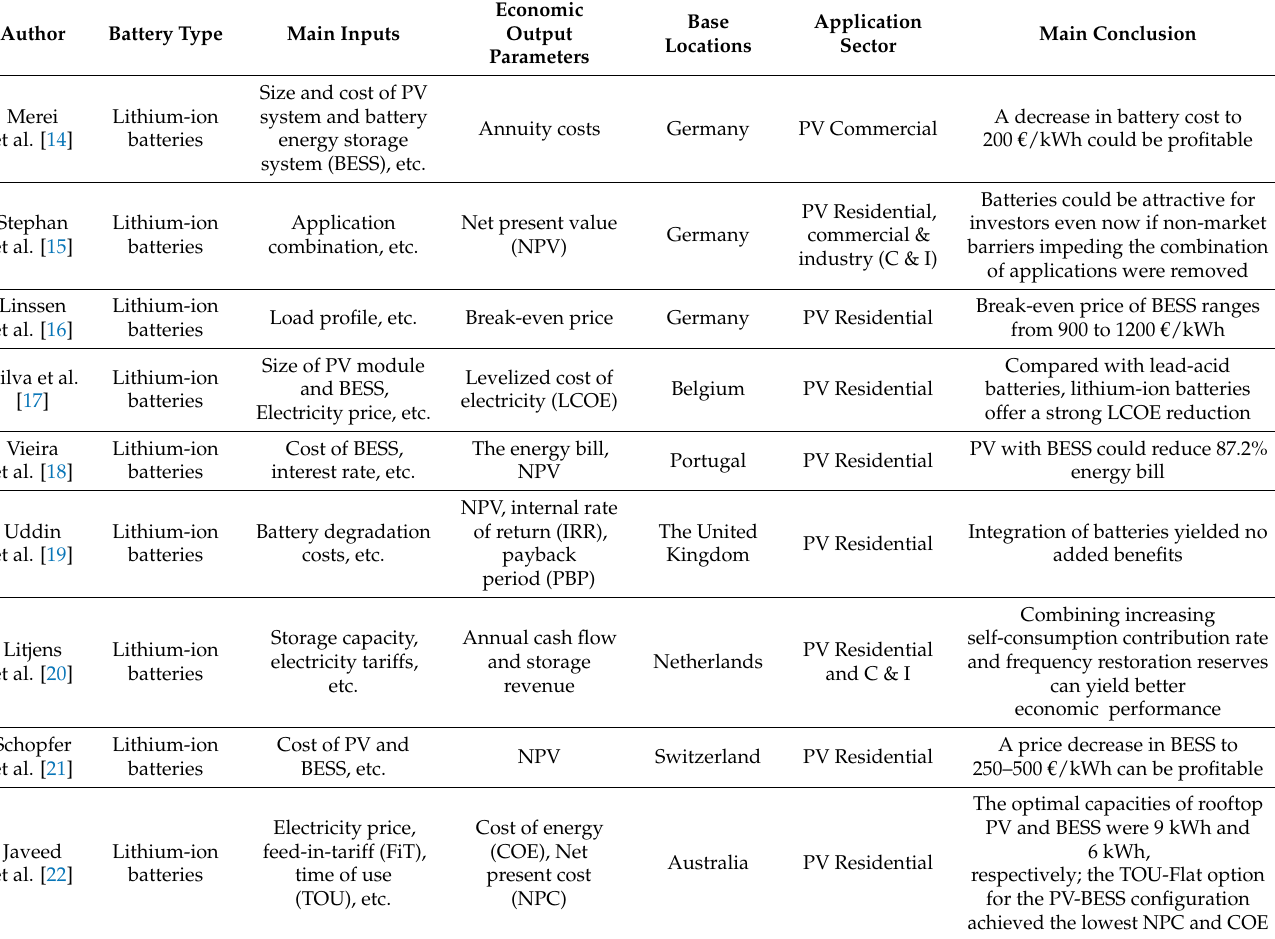
Table 2. Summary of research related to economic analysis of renewable energy + energy storage system (ESS) integrated systems. Developed with permission from Elsevier, 2022